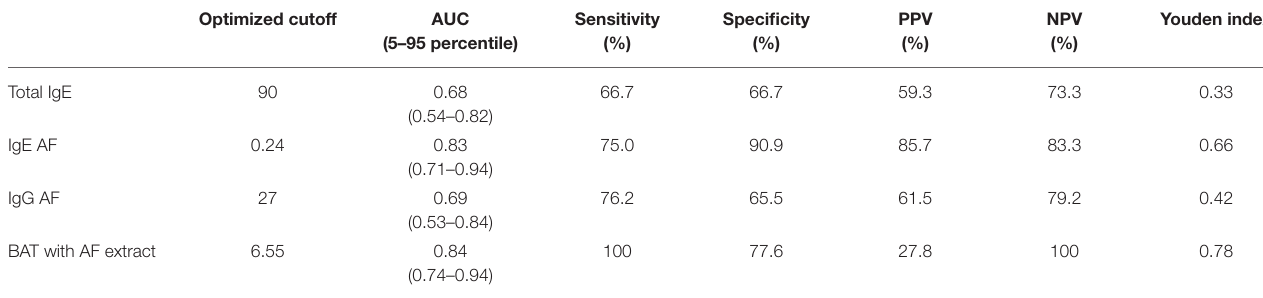
TABLE 2 | Performance analysis of total and specific immunoglobulins and cellular functional assays with the optimized